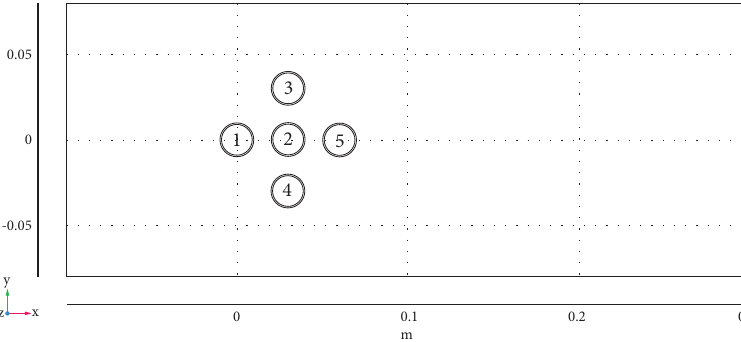
Figure 19: Five-tube bundle calculation